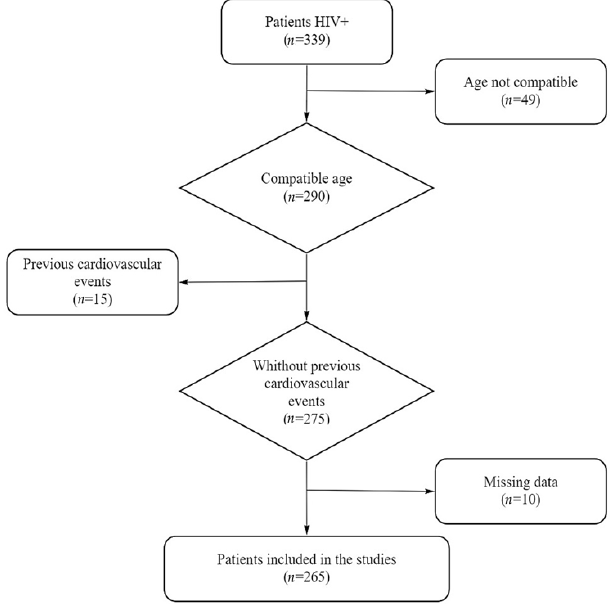
Figure 1. Study inclusion flowchart .